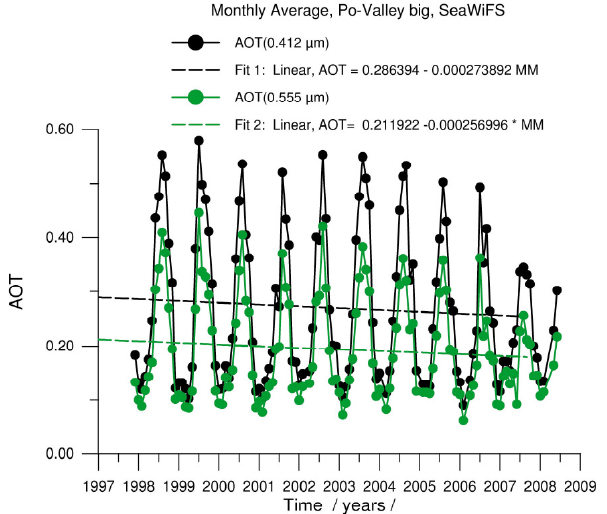
Fig. 22b. Po-Valley-big.